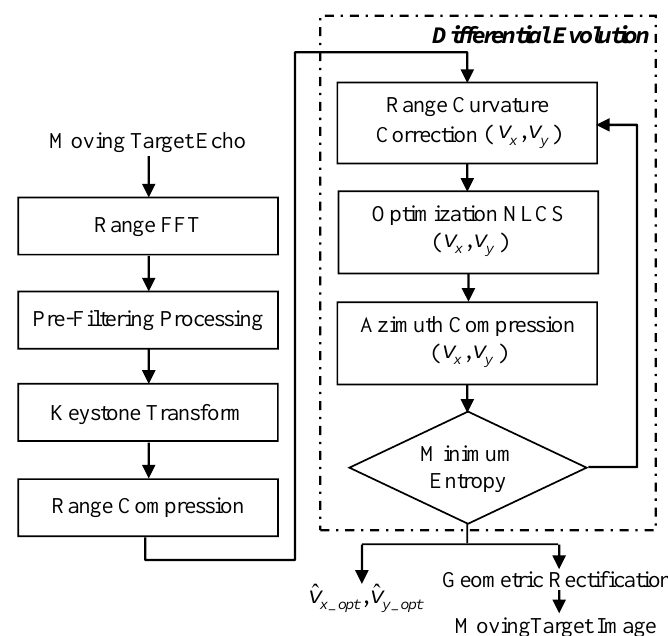
Figure 2. The flowchart of the proposed